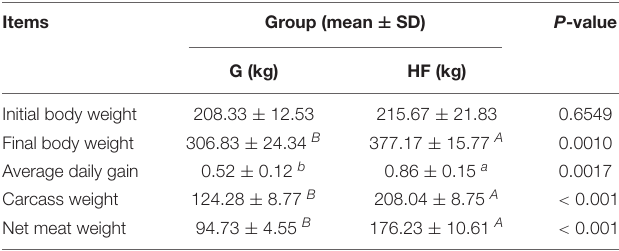
TABLE 1 | The growth performance of yaks in different feeding